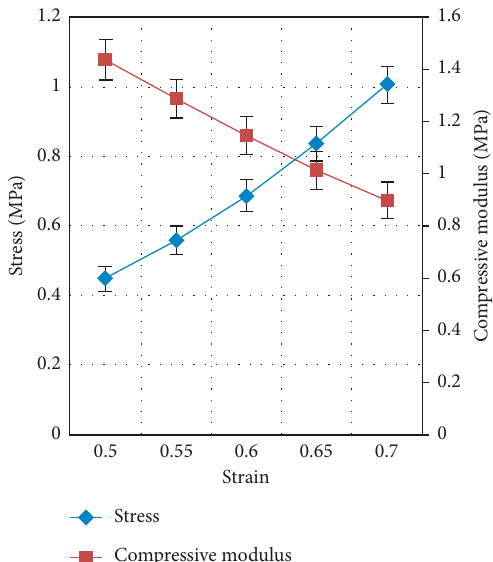
Figure 11: Stress-strain relationship and compressive